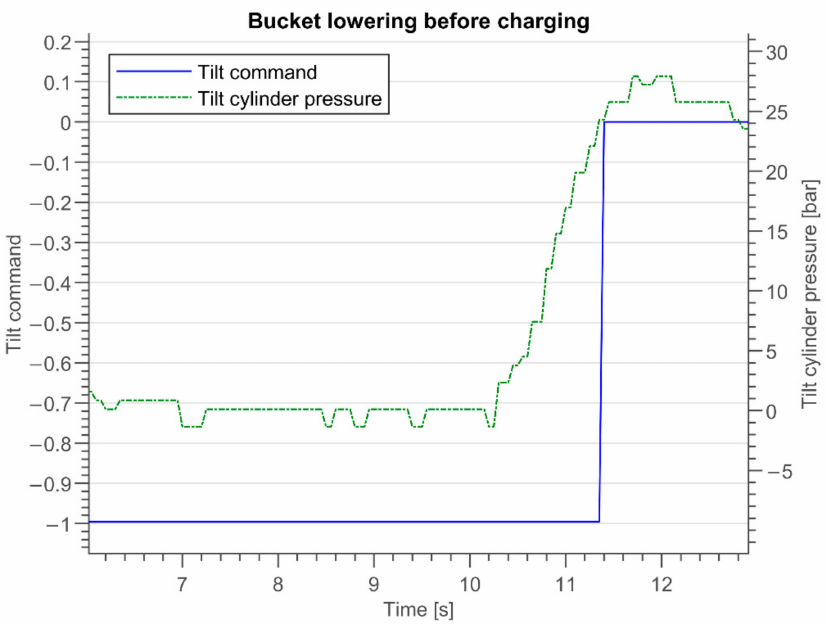
Figure 14. Cylinder pressure increase as the bucket is tightly pressed against the ground in prepara- tion for the charging